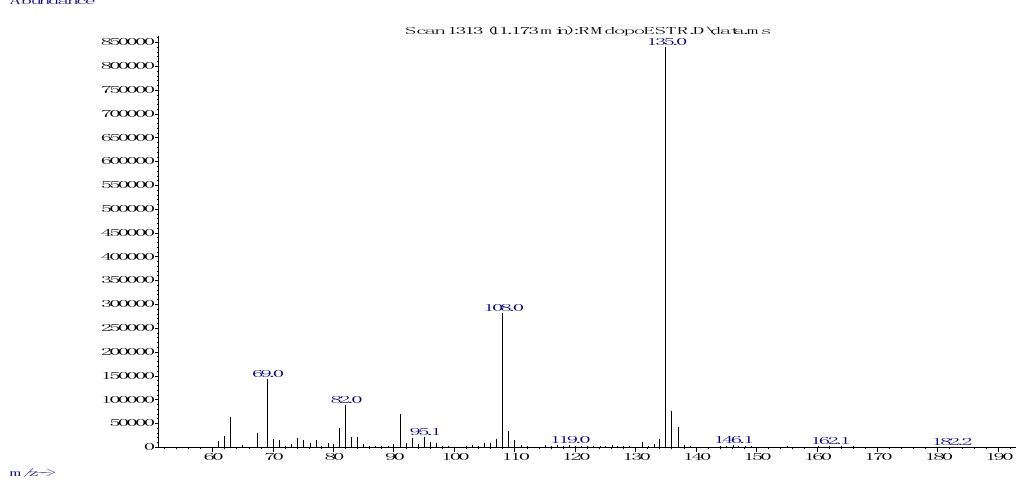
Figure A3. MS spectrum of benzothiazole, r.t 11.17 min.